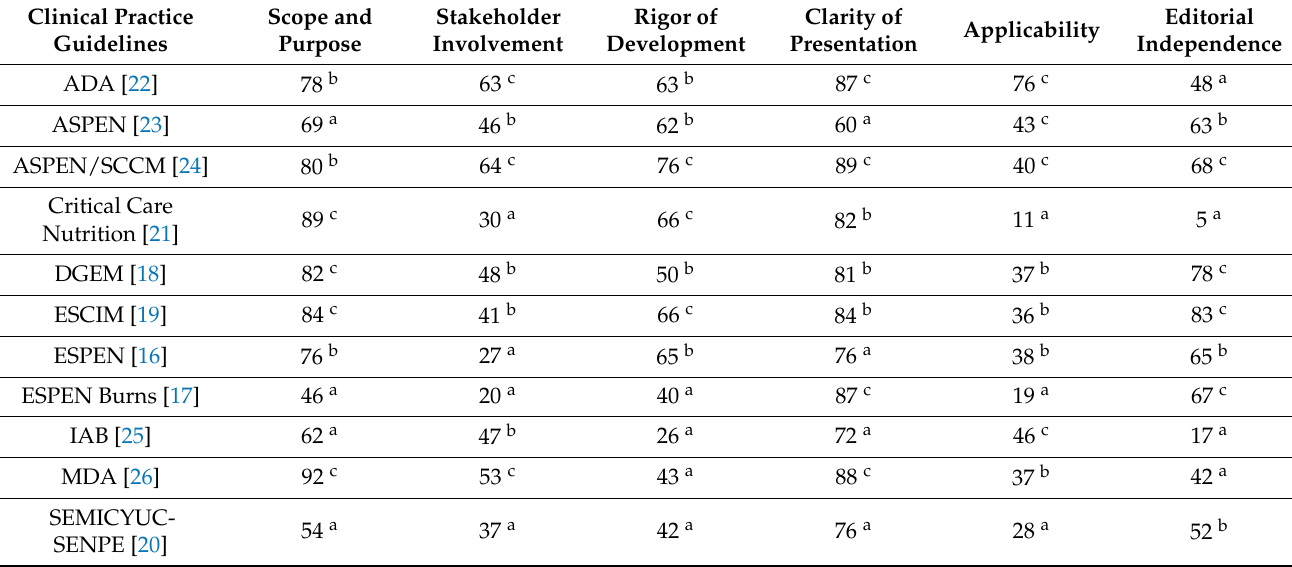
Table 2. Scaled domain scores using the AGREE II tool